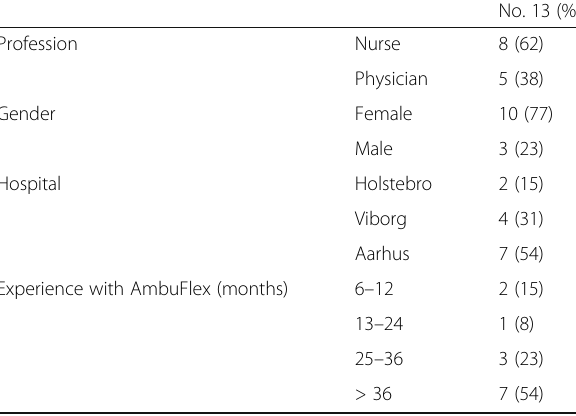
Table 3 Clinician participant profile, individual